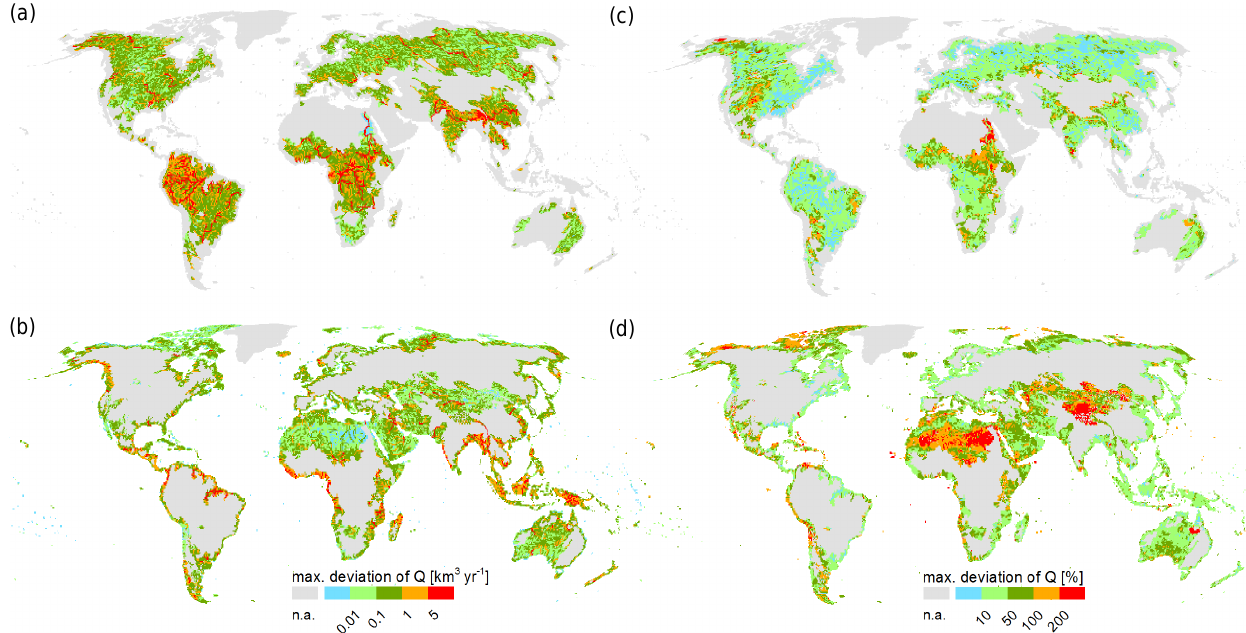
Figure 3. Spatial distribution of the maximum difference of long-term average (1971–2000) Q among the four homogeneous climate forcings (GSWP3, PGFv2.1, WFD, WFDEI_hom), expressed as absolute deviation (km 3 yr − 1 ) (a, b) and relative deviation (c, d) separately for calibrated (a, c) and non-calibrated (b, d) regions. Grey areas contain either no discharge or are outside the region of interest, i.e., non- calibrated regions are grey in (a) and (c) and vice